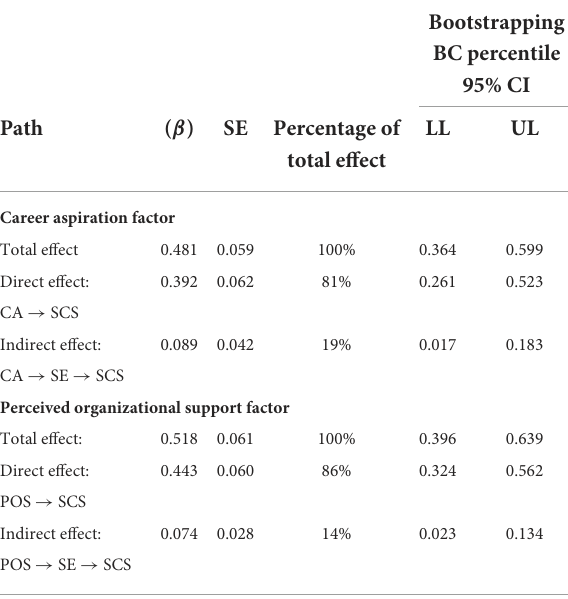
TABLE 4 Bootstrap analysis of mediating effects of